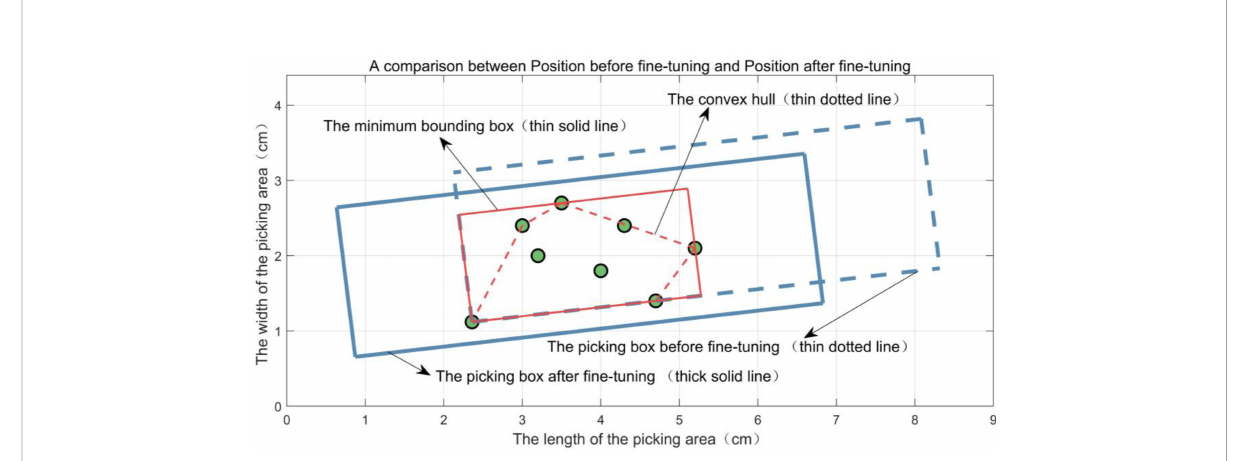
FIGURE 11 Position comparison of a picking box before and after fi ne-tuning its foothold parameters.